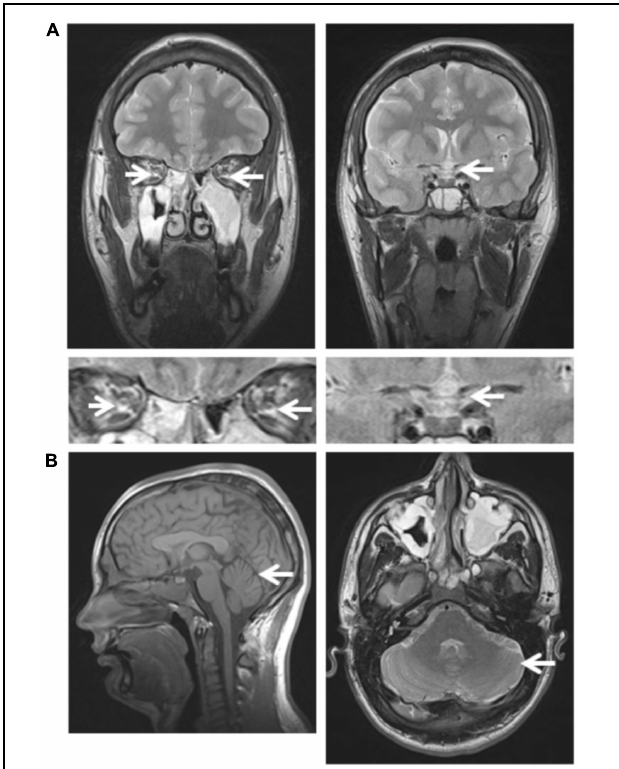
FIGURE 3 | Brain MRI of patient III.4 at 18 years of age. (A) Left: Frontal section, T2 sequence, showing atrophy of the optic nerve (arrow) and Right: reduced size of the chiasma (arrow). Magnification of the optic track (Left) and chiasma (Right) regions are shown underneath the full picture. (B) Left: Sagittal section, T1 sequence, showing a normal aspect of the brain, especially of the vermis (arrow); Right: axial section, T2 sequence, showing a normal aspect of the posterior fossa, especially the cerebellar hemisphere (arrow).